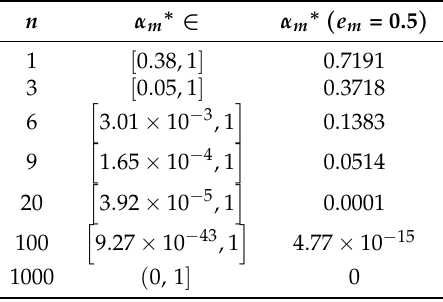
Table 2. α m ∗ changes with different n